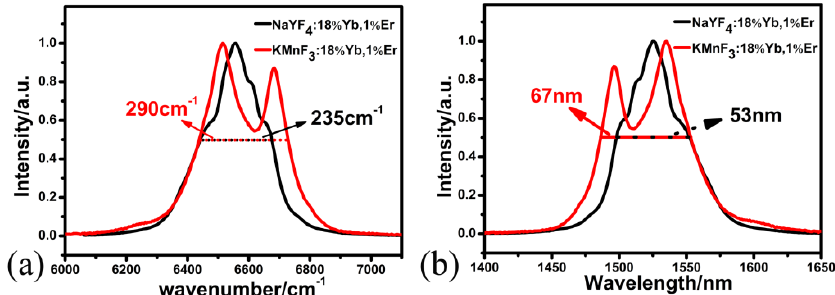
Figure 4. ( a , b ) Normalized down-shifting fluorescence spectra of NaYF 4 :18%Yb 3+ ,1%Er 3+ NPs and KMnF 3 :18%Yb 3+ ,1%Er 3+ NPs at the maximum value under diode laser excitation at 980 nm, where ( a ) the x -axis is wavenumber/cm − 1 and ( b ) the x -axis is wavelength/nm.